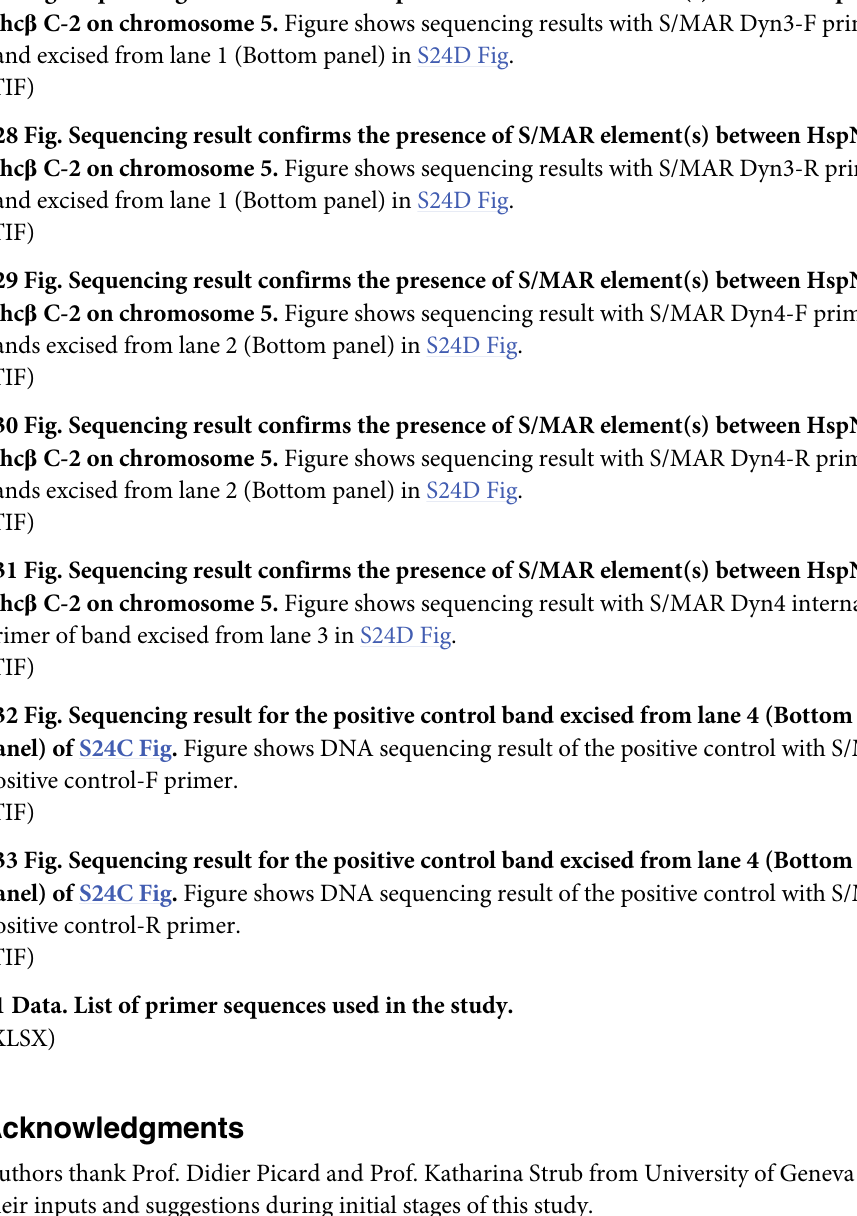
S27 Fig. Sequencing result confirms the presence of S/MAR element(s) between HspN & Dhc β C-2 on chromosome 5. Figure shows sequencing results with S/MAR Dyn3-F primer of band excised from lane 1 (Bottom panel) in S24D Fig. S28 Fig. Sequencing result confirms the presence of S/MAR element(s) between HspN & Dhc β C-2 on chromosome 5. Figure shows sequencing results with S/MAR Dyn3-R primer of band excised from lane 1 (Bottom panel) in S24D Fig. S29 Fig. Sequencing result confirms the presence of S/MAR element(s) between HspN & Dhc β C-2 on chromosome 5. Figure shows sequencing result with S/MAR Dyn4-F primer of bands excised from lane 2 (Bottom panel) in S24D Fig. S30 Fig. Sequencing result confirms the presence of S/MAR element(s) between HspN & Dhc β C-2 on chromosome 5. Figure shows sequencing result with S/MAR Dyn4-R primer of bands excised from lane 2 (Bottom panel) in S24D Fig. S31 Fig. Sequencing result confirms the presence of S/MAR element(s) between HspN & Dhc β C-2 on chromosome 5. Figure shows sequencing result with S/MAR Dyn4 internal-F primer of band excised from lane 3 in S24D Fig. S32 Fig. Sequencing result for the positive control band excised from lane 4 (Bottom panel) of S24C Fig. Figure shows DNA sequencing result of the positive control with S/MAR positive control-F primer. S33 Fig. Sequencing result for the positive control band excised from lane 4 (Bottom panel) of S24C Fig. Figure shows DNA sequencing result of the positive control with S/MAR positive control-R